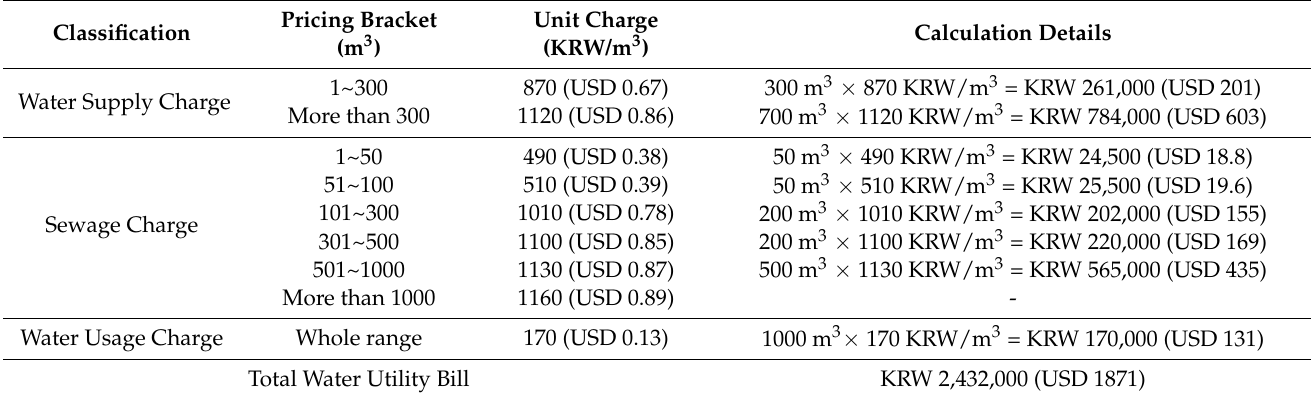
Table 2. A water utility bill for 1000 m 3 of water in Incheon, South Korea (USD 1 = KRW 1300).